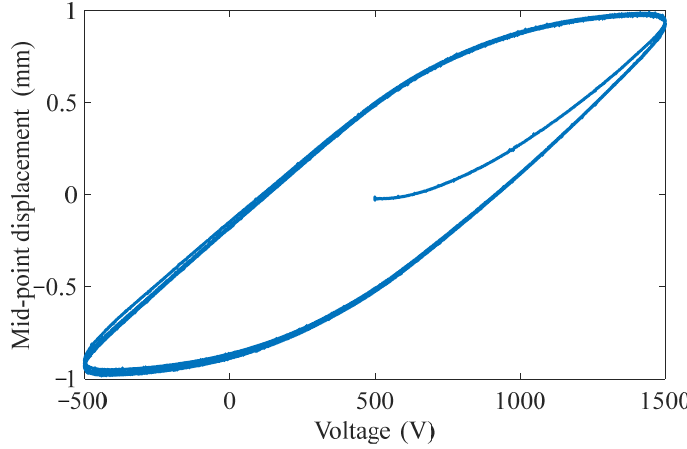
Figure 5. Hysteresis loop of mid-point displacement of MFC-PBP versus quasi-static excitation voltage. Then, the relative error (RE) is used as the measurement of the prediction accuracy, and its expression is